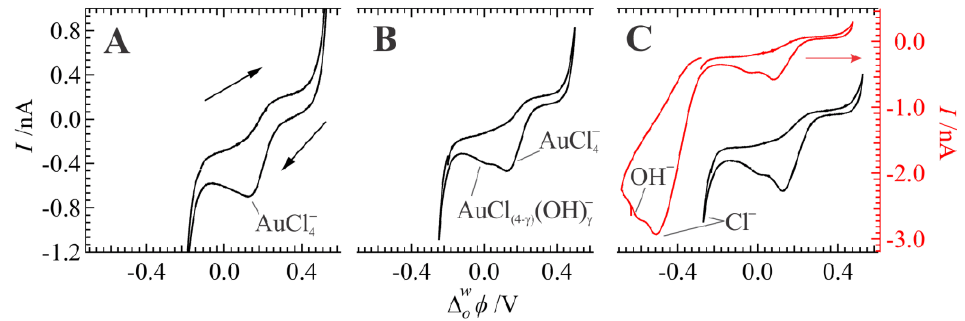
Figure 2. Cyclic voltammograms (CVs) measured using Cells 1a–3a ( A – C ) with no electron donor added to the DCE phase. 1 mM of KAuCl 4 was dissolved in the aqueous phase with the pH = 2, 5.5–6, and 8.5 for the top, middle, and bottom panels, respectively. A 25 µm diameter ITIES was used with a scan rate of 0.020 V s –1 . The red arrow indicates the axes plotted against, black arrows indicate scan direction, and the peak currents have been labelled with the associated simple ion transfer process taking place.